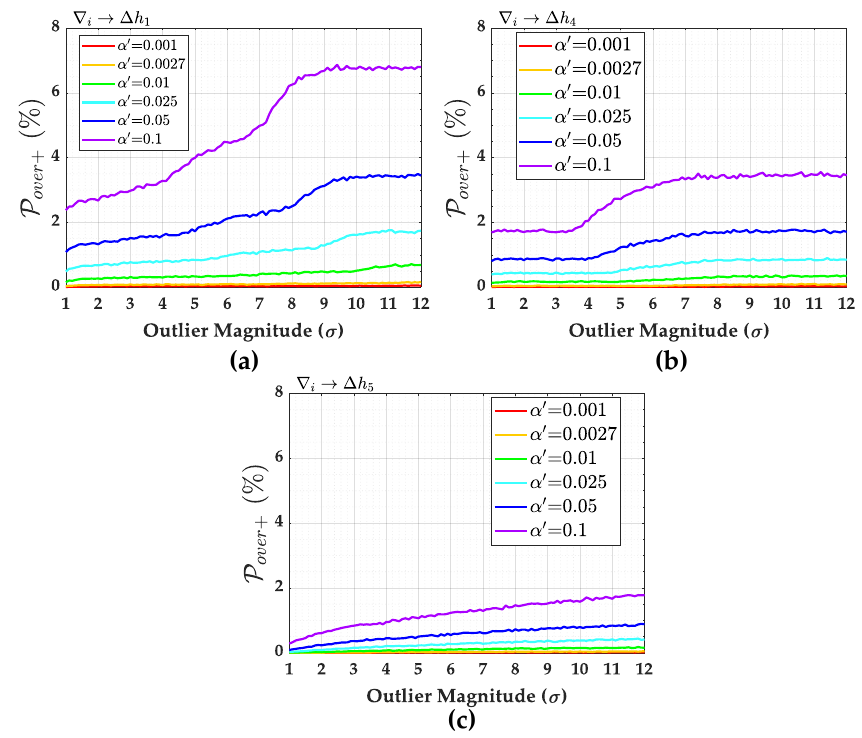
Figure 22. Probability of over-identification ( P over + ) for network ( b ). ( a ) P over + for ∆ h 1 . ( b ) P over + for ∆ h P over + for ∆ h 5 . 4 . ( c )